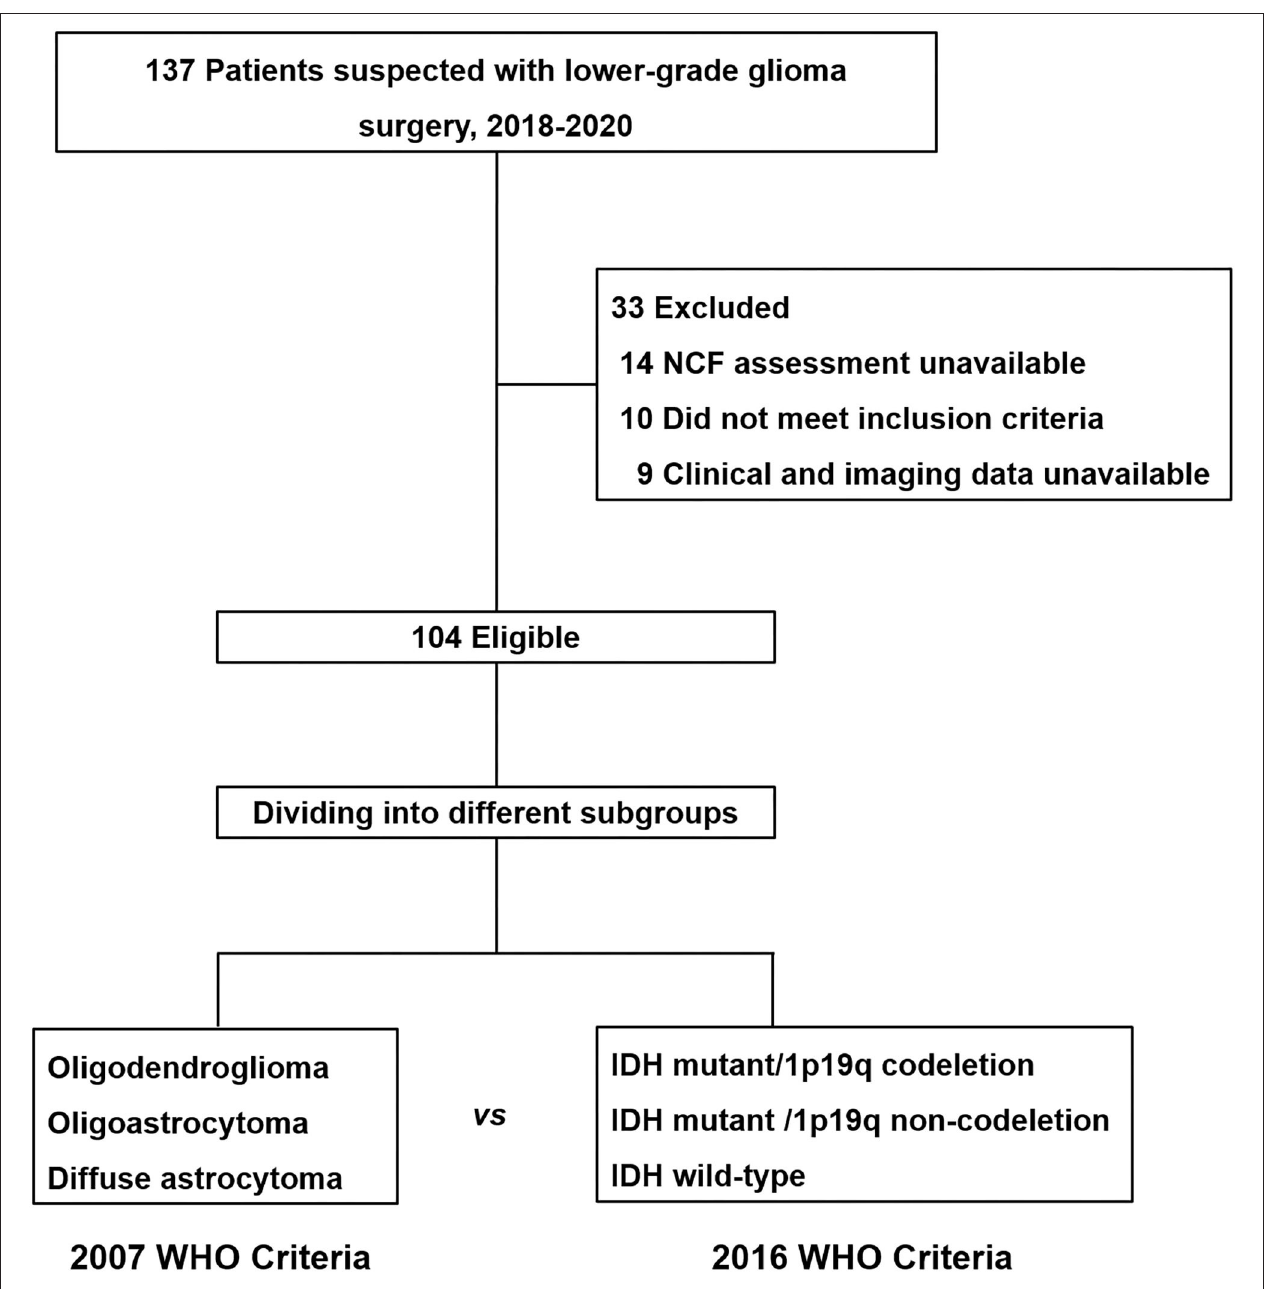
FIGURE 1 | Flow diagram for neurocognitive function assessment cohort. All patients enrolled for this study were divided into different subgroups according to the molecular-integrated 2016 CNS WHO and morphology-centric 2007 CNS WHO to compare their neurocognitive function dysfunction.